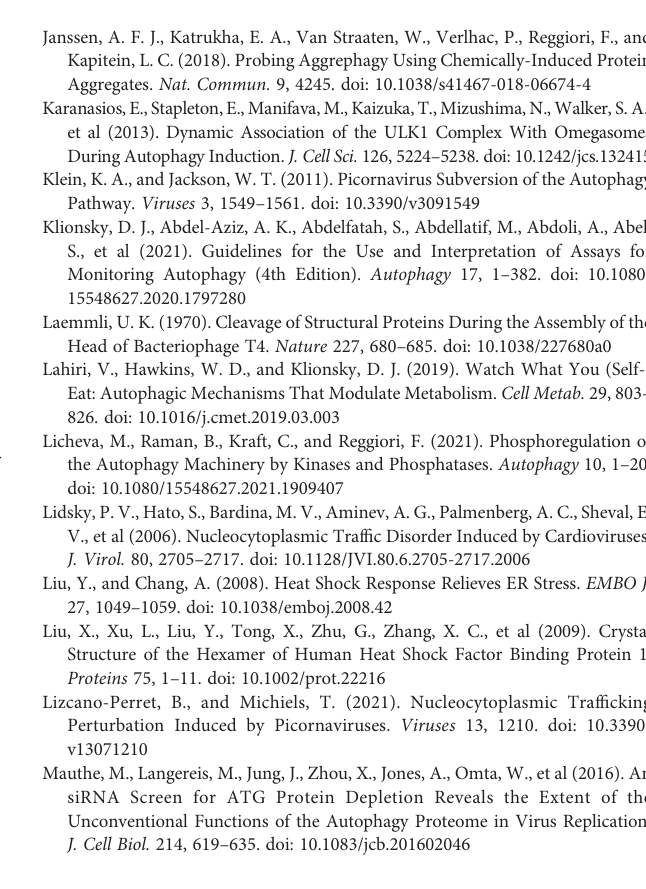
Supplementary Figure 4 | Depletion of HSBP1 in U2OS cells. (A) Original, uncropped WB used for Figure S1B . HSBP1 and tubulin bands used for fi gure S1Bare indicated inredsquares. (B) Original,uncroppedWB usedfor FigureS2A . HSBP1 and tubulin bands used for Figure S2A are indicated in red